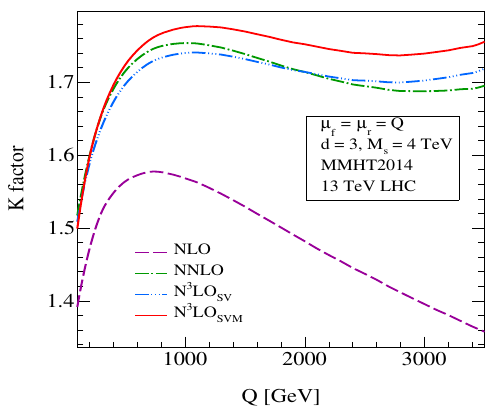
Figure 8 . The ADD (gravity only) K-factors up to N 3 LO for combined gg + q (cid:22) q channels. At the third order the K-factors are for the conventional SV and for the modi(cid:12)ed SV (SVM) with h ( z ) = z .